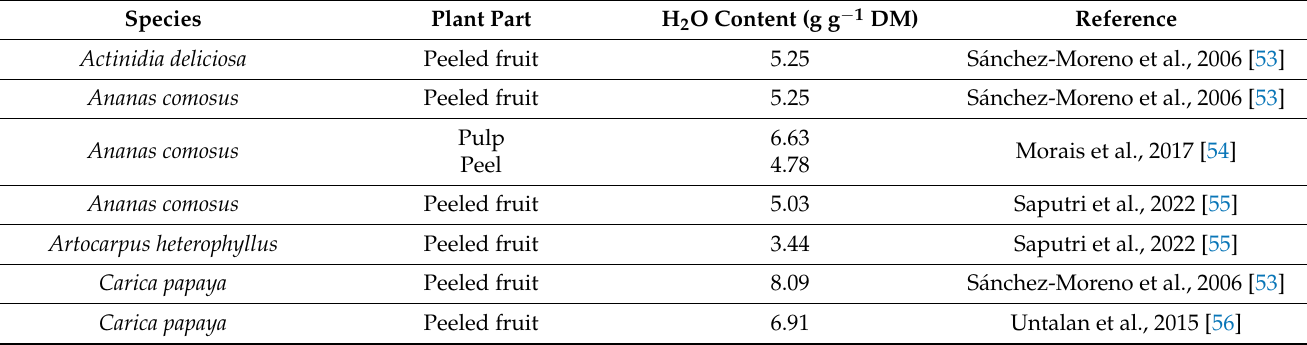
Table 2. Examples of differences in tissue water content values in fruits of various plant species. Species Plant